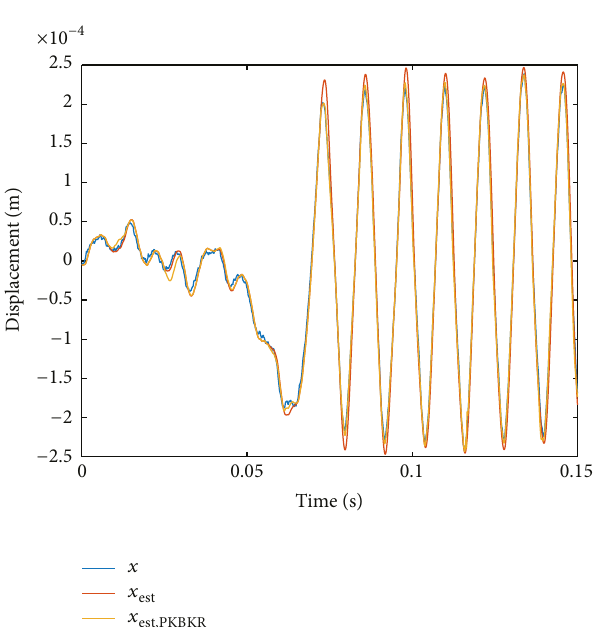
Figure 3: Measured and estimated displacements. Y -direction, experiment